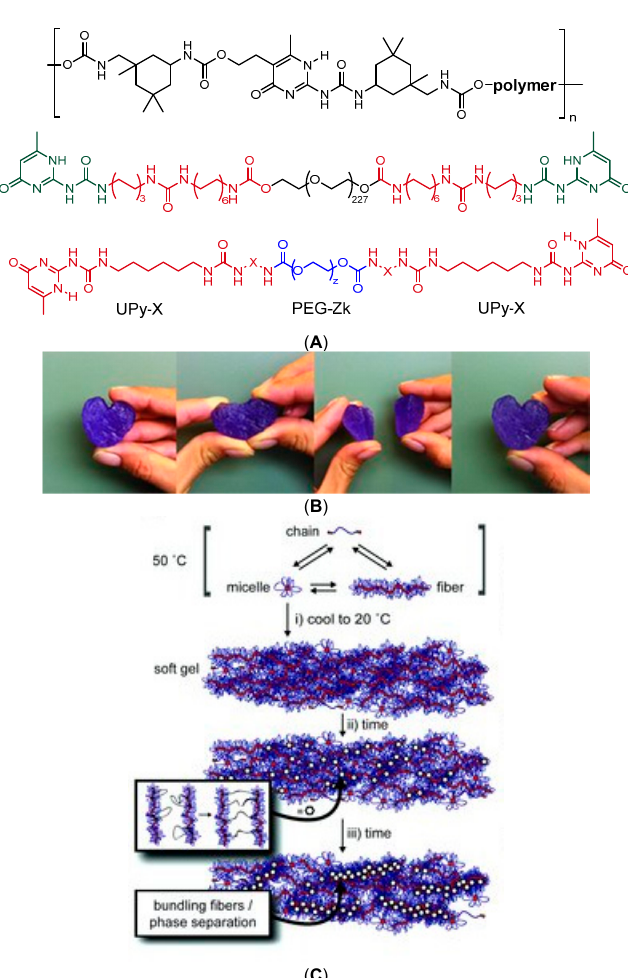
Figure 10. ( A ) Examples of the structures of PEG-based H-bonding polymers that contain UPy units as part of main chain [128] or as end groups [129,130]; ( B ) Visual demonstration of the self-healing of a 15 wt% hydrogel of the main-chain-functionalized polymer of (a). Purple dye was added for demonstration purposes [128]; ( C ) At high temperatures (above 50 °C) and in dilute solution, the hydrogelators are present as three species: single chain, spheric micelle, and fiber: ( i ) Upon cooling, or increase in concentration, a soft hydrogel is formed; ( ii ) After a time span of approximately 16–24 h, the strength of the gel is increased due to the formation of supramolecular cross-links; and ( iii ) The fibers may bundle and phase separate forming ordered domains in the hydrogel network. Reprinted with permissions from [128,129]. Copyright 2016 John Wiley and Sons.